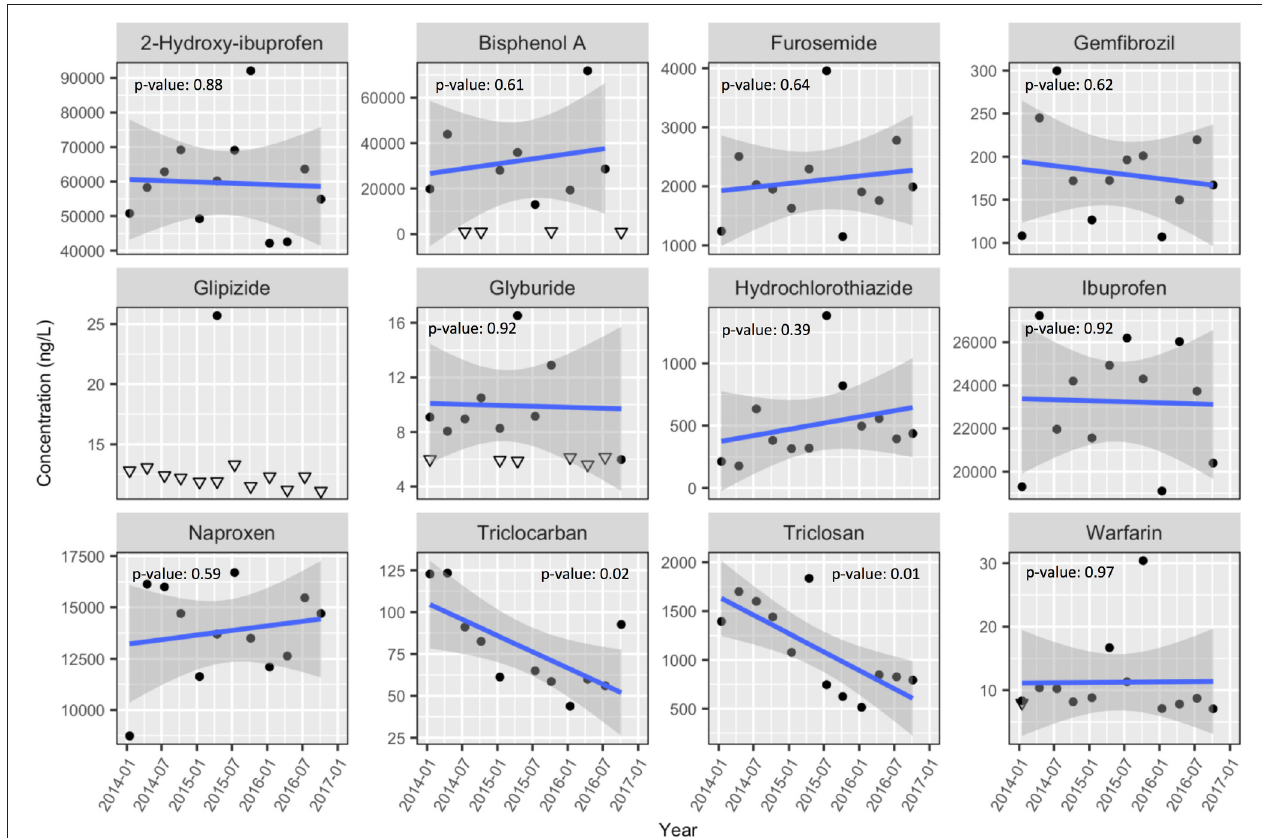
FIGURE 2 | Filtered wastewater PPCP concentrations in MAC wastewater pre-discharge. Solid blue lines are linear fits (with p -value) with the gray banding representing 95% confidence intervals. Split lab replicates were averaged; non-detected values are marked with their sample specific detection limit as downward facing open triangles. Post-2014 data are presented separately from 2009 data due to changes in analytical methods. For full statistics see Table S7.